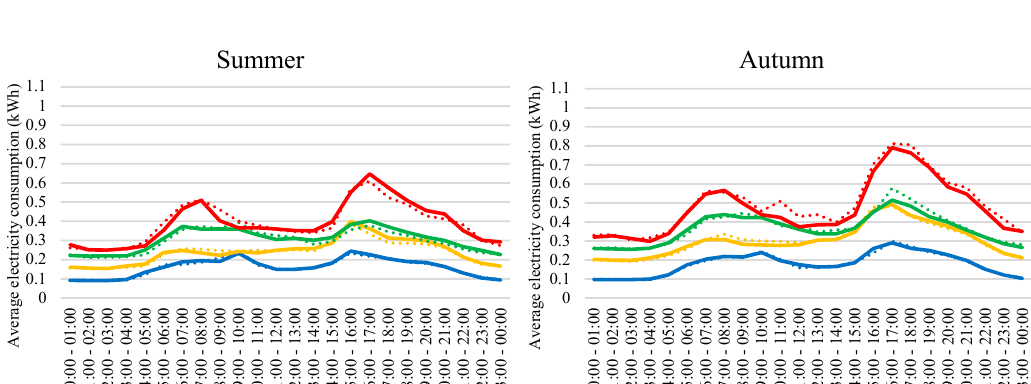
weekends for the four clusters. for the four